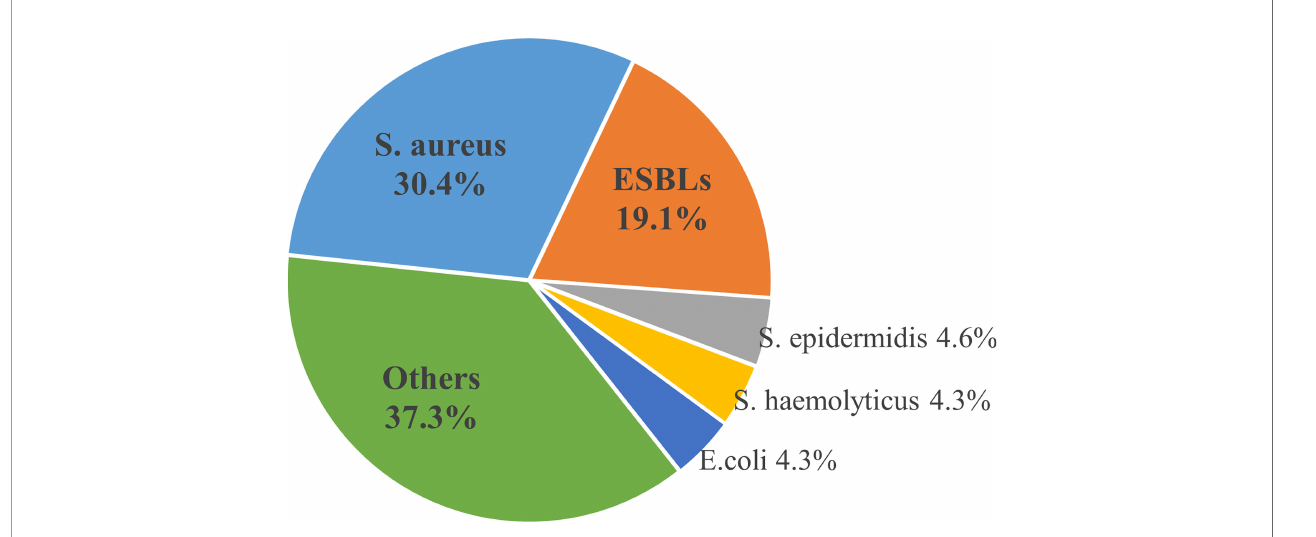
FIGURE 2 | Distribution of common Multiple Drug Resistant